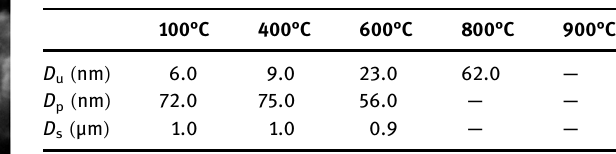
Table 1: Size changes of particles inside metatitanic